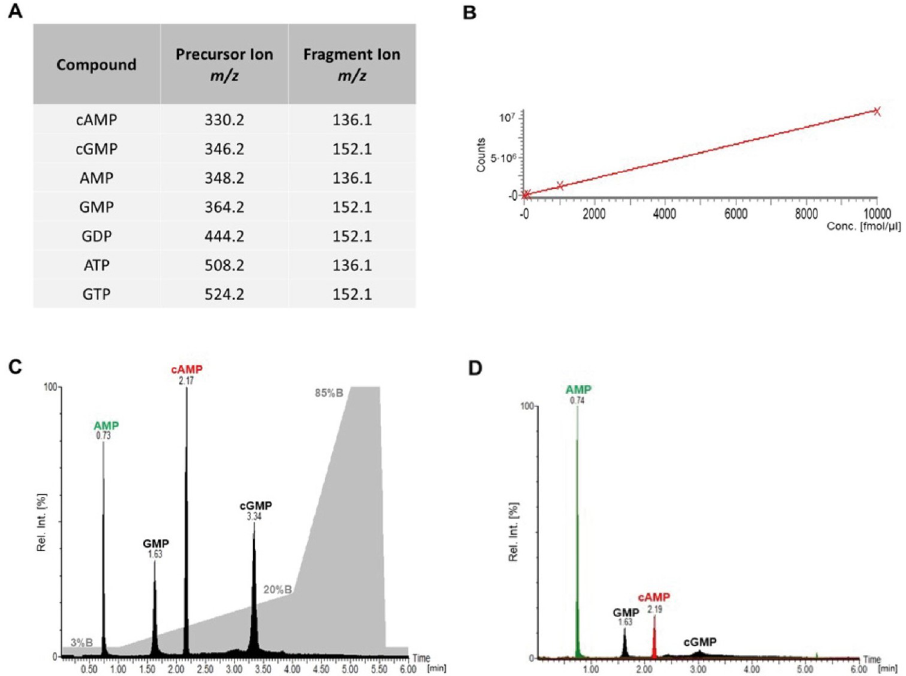
Fig 4. ( A ) Selected transitions in triple-quadrupole MS/MS measurements for selected nucleotides. ( B ) Linearity of mass spectrometric response for cAMP in the concentration range between 0–10 pmol/ μ l. (C) LC-MRM-MS/MS analysis (100 fmol) of four selected nucleotides (AMP, cAMP, GMP, cGMP). The TIC (Total Ion Current) of the LC elution is shown in black, the LC gradient is shown in grey (%B). ( D ) LC-MRM-MS/MS of filtrates (see Fig 2) for selected